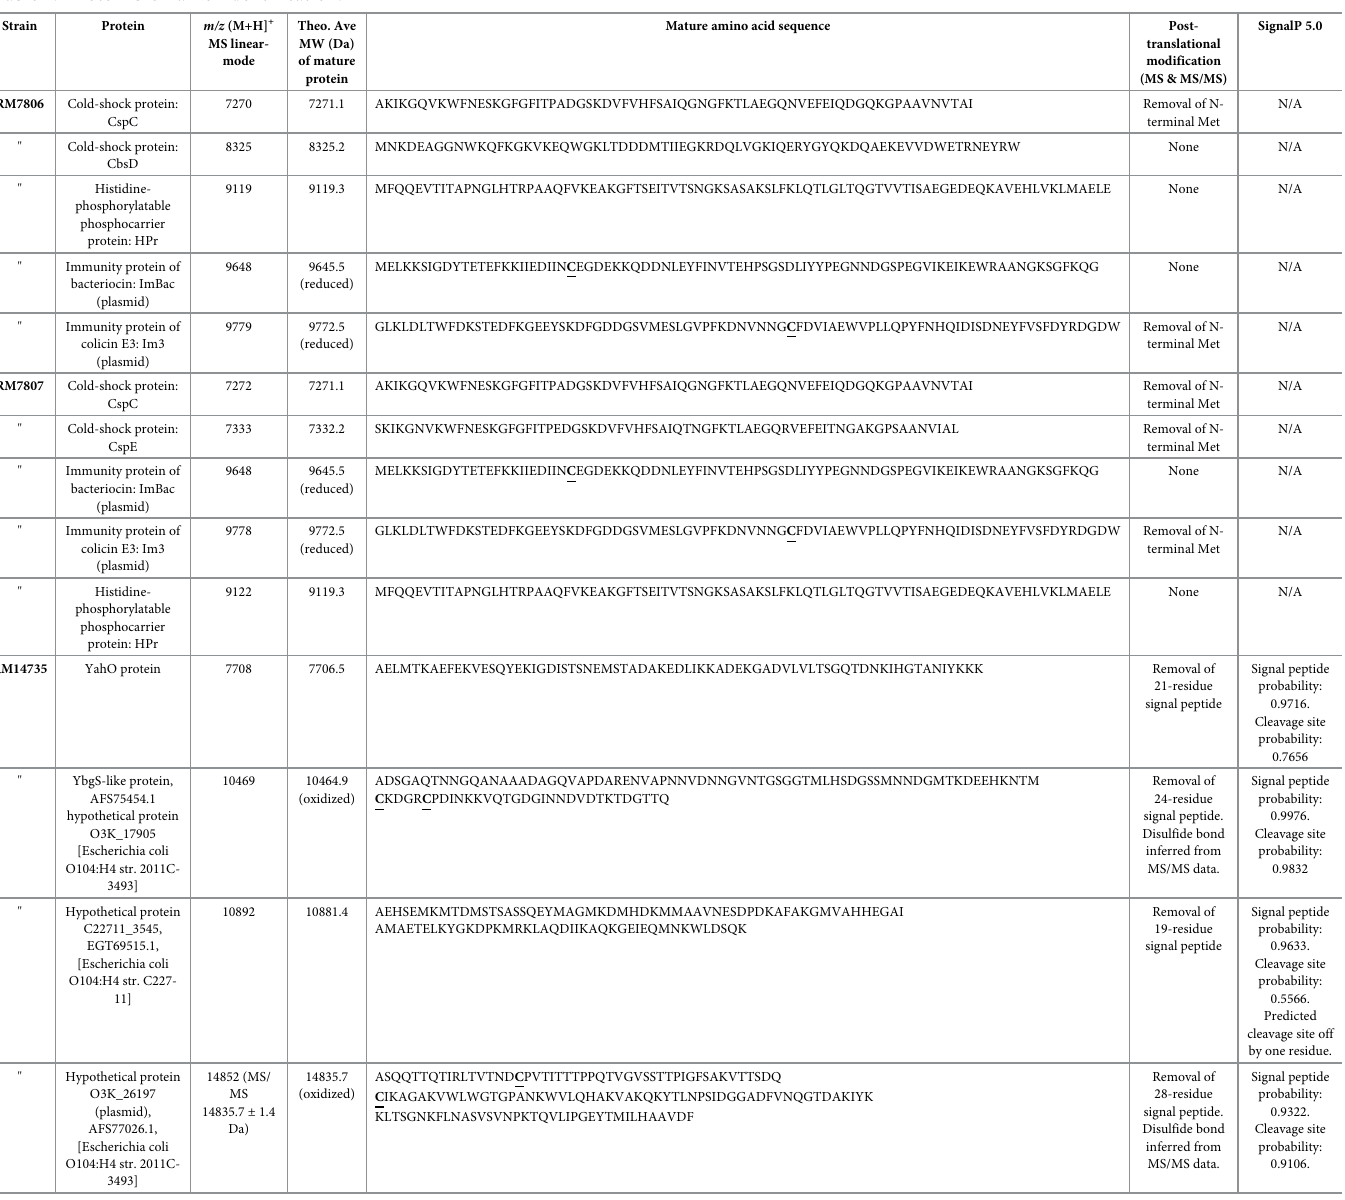
Table 1. Protein biomarker identification.